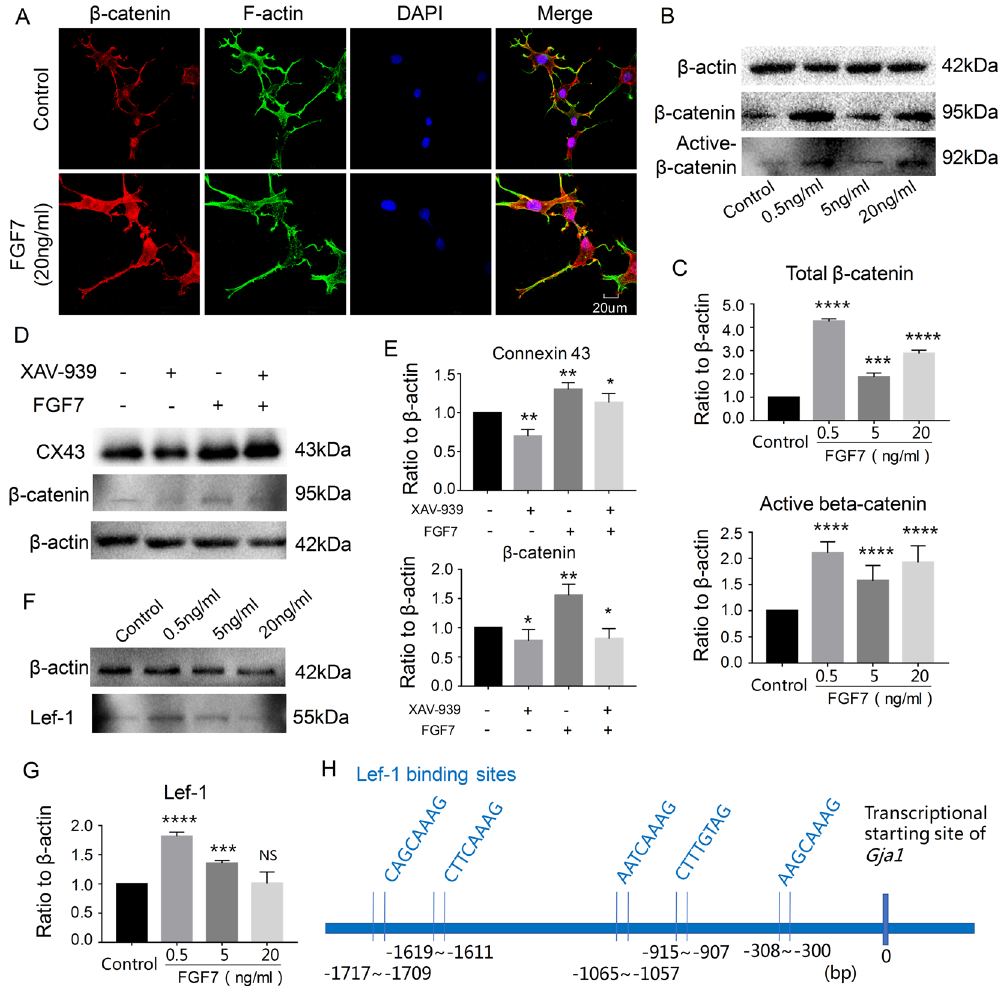
Figure 6. The gap junction elongated through beta-catenin transduction. ( A ) Immunofluorescent stain showed the nuclear accumulations of beta-catenin in osteocytes at 24 h after treatment with FGF7 (20 ng/ml). The images shown are representative of three different experiments (n = 3). ( B ) Western blot showed beta-catenin and active beta-catenin expressions after FGF7 induction increased in a concentration-dose (0.5, 5 and 20 ng/ ml) dependent manner. Cell lysates were collected at 48 h following FGF7 treatments for beta-catenin, active beta-catenin and beta-actin; the images were collected from two gels with the same loading amounts. The blot gels shown are representatives of three different experiments (n = 3). ( C ) Quantitative analysis of western blots of ( B ) with Image-J software 6.0. The data shown are representative of three independent experiments (n = 3). *** P < 0.001, **** p < 0.0001. ( D ) Western blot showed the inhibitor of β -catenin, XAV-939, reduced the Cx43 level. In the presence of FGF7, β -catenin inhibition partially reduced the Cx43 in relative to FGF7 induction group. The blot gels shown are representatives of three different experiments (n = 3). ( E ) Quantitative analysis of western blots ( D ) with Image-J software 6.0. The data shown are representative of three independent experiments (n = 3). * P < 0.05, ** P < 0.025. ( F ) Western blot showed Lef-1 expressions after FGF7 induction increased in a concentration-dose (0.5, 5 and 20 ng/ml) dependent manner. ( G ) Quantitative analysis of western blots of ( F ) with Image-J software 6.0. The data shown are representative of three independent experiments (n = 3). *** P < 0.001, **** p < 0.0001, NS, no significant difference. ( H ) The bioinformatics showed that Lef1 has the binding sites in the promoter of Gja1 , the gene name of